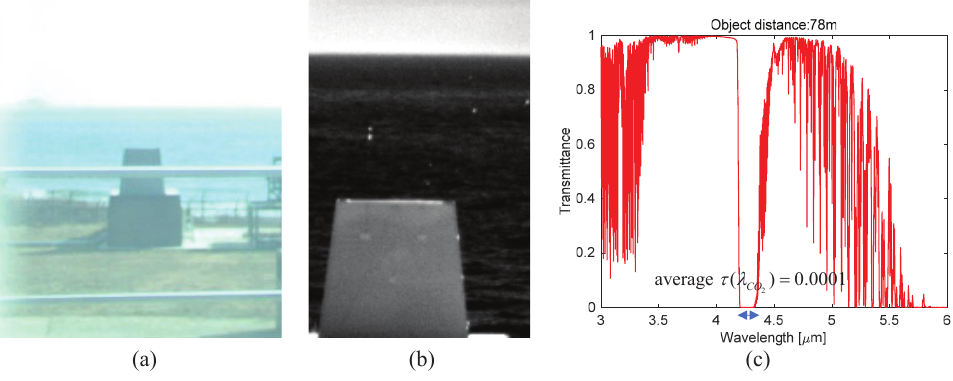
Figure 16. An example of experiment environment: ( a ) outdoor environment acquired by a visible band camera, ( b ) broad-band infrared image, and ( c ) spectral transmittance in MWIR